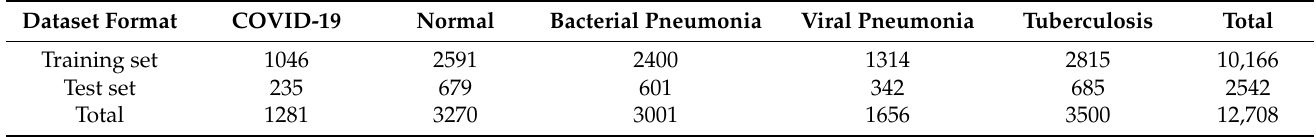
Table 2. Division of